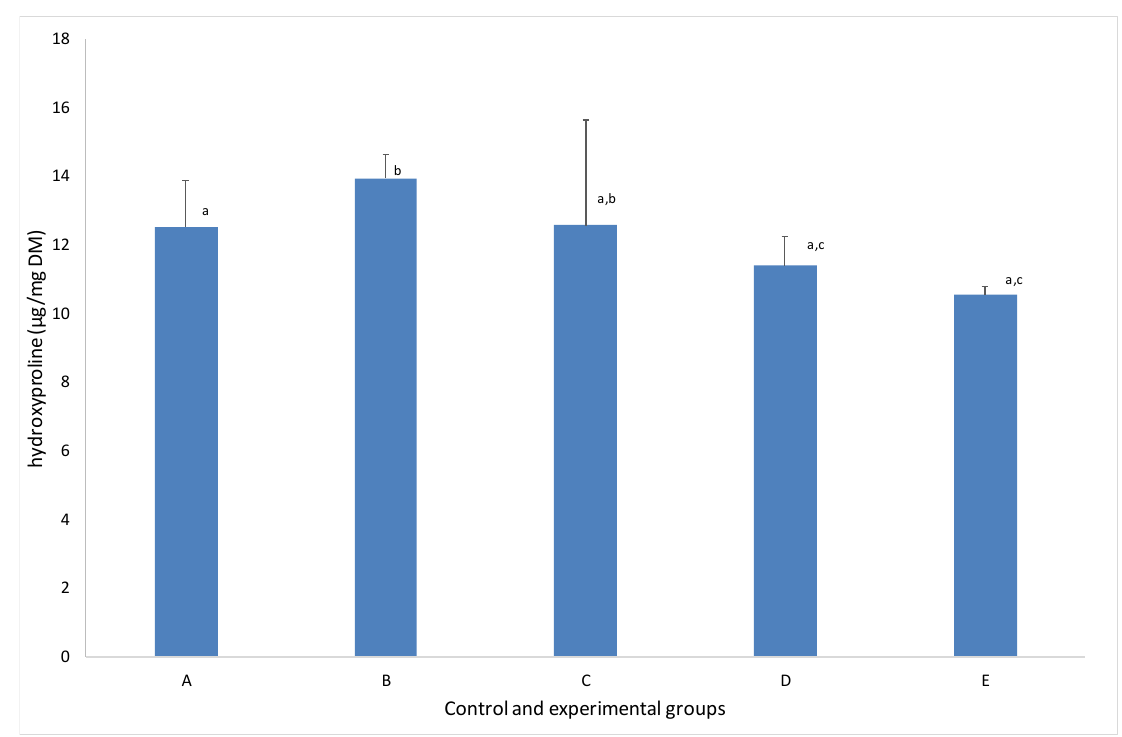
Figure 3. Bone hydroxyproline concentration in the control and experimental groups. Values are the mean ± SD. (a, b, c) Values in rows with different letters differ significantly ( p ≤ 0.05; Tukey’s HSD test).